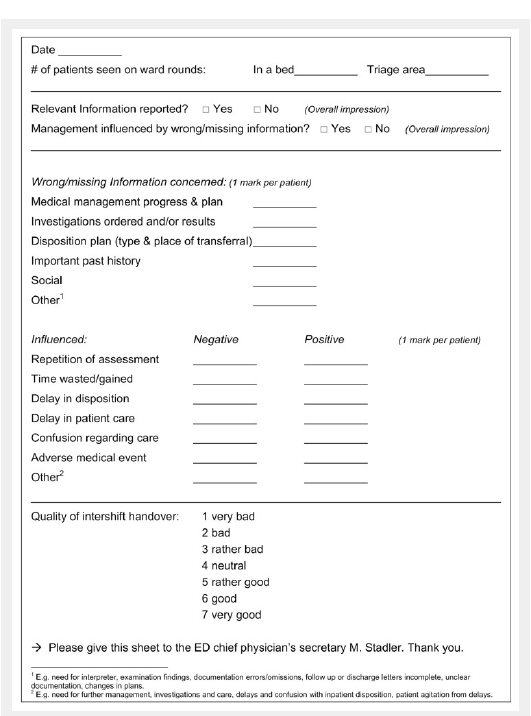
Post-clinical rounds questionnaire of senior ED physicians. Missing or wrong information as well as adverse events were counted. Each category could be mentioned only once per